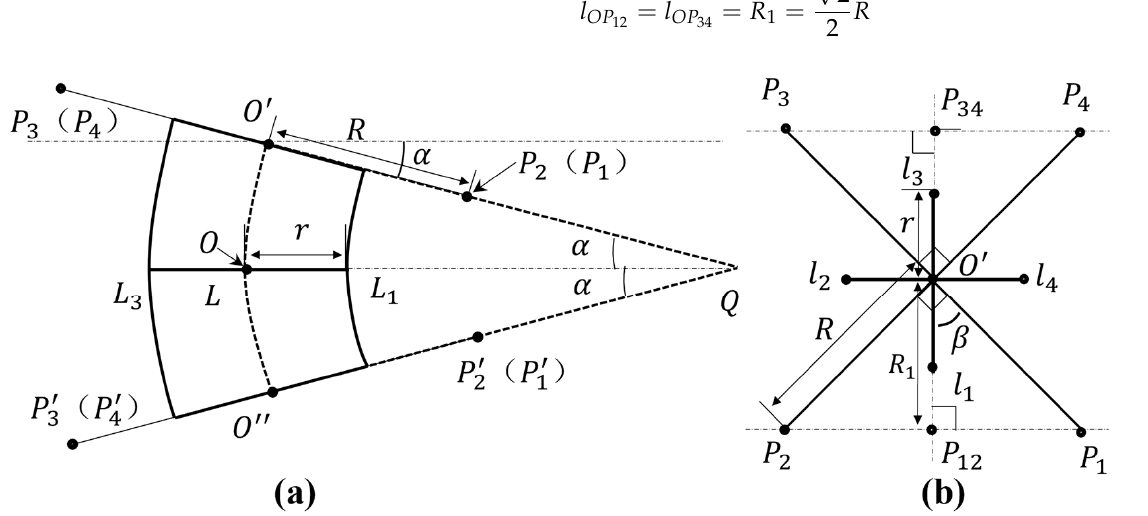
Figure 6. Three-dimensional simplified model of the module. ( a ) 3D simplified solid model of the module. ( b ) Geometric model of module element in bending.